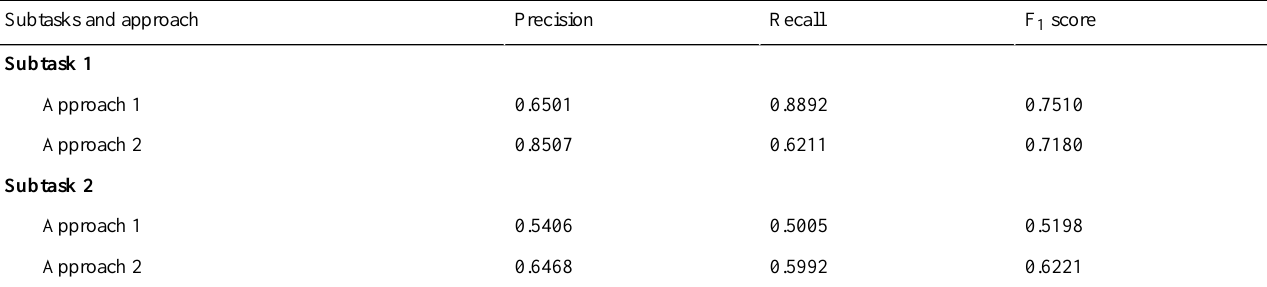
Table 3. Original overall test results for the 2 national natural language processing clinical challenges subtasks; approach 1: shortest dependency path and coreference resolution and approach 2: rule-based engine.